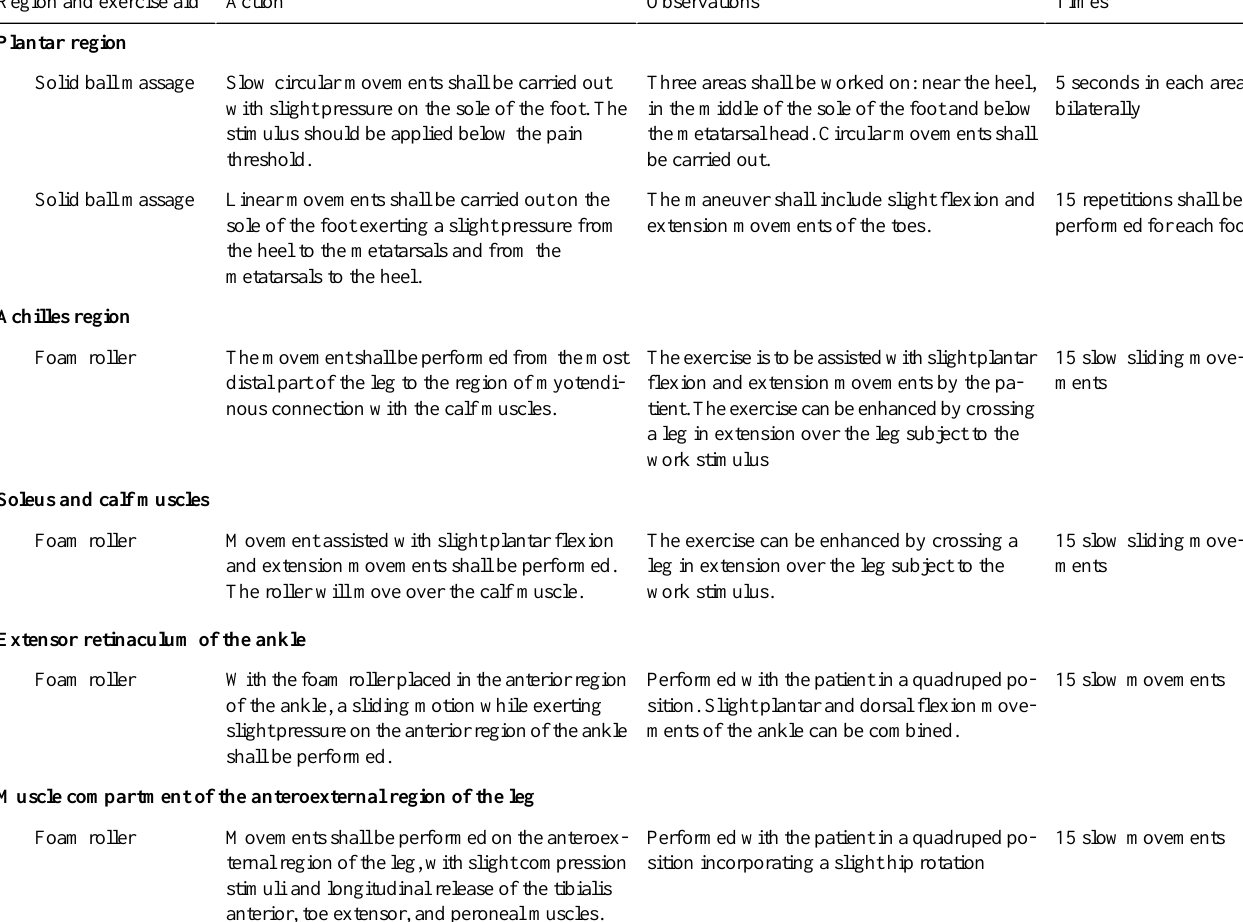
Table 1. Physiotherapy protocol using self-myofascial release for patients with hemophilic ankle arthropathy. TimesObservationsActionRegion and exercise aid Plantar